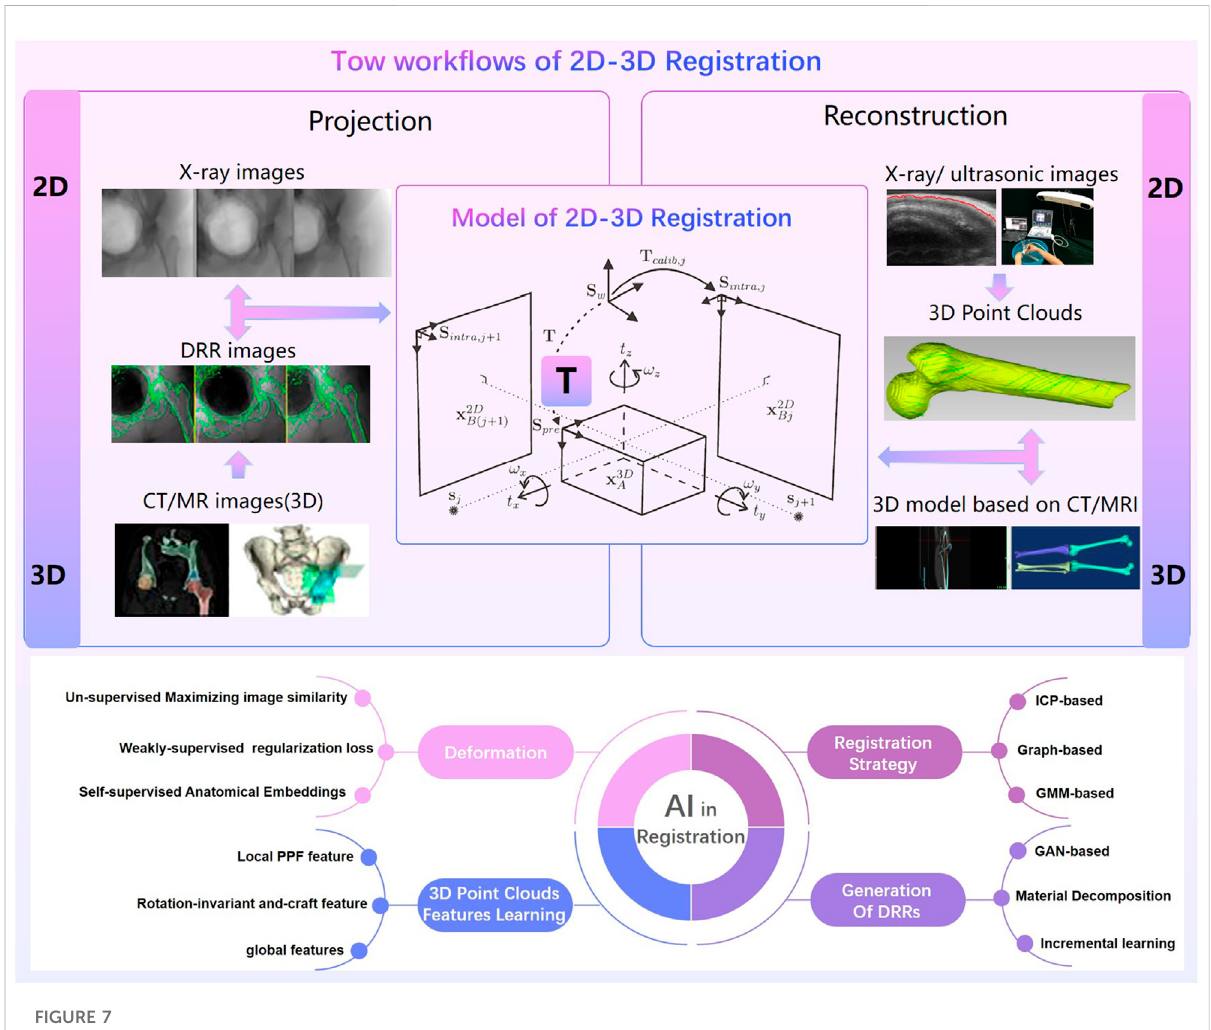
FIGURE 7 Tow work fl ows of 2D-3D Registration and AI in